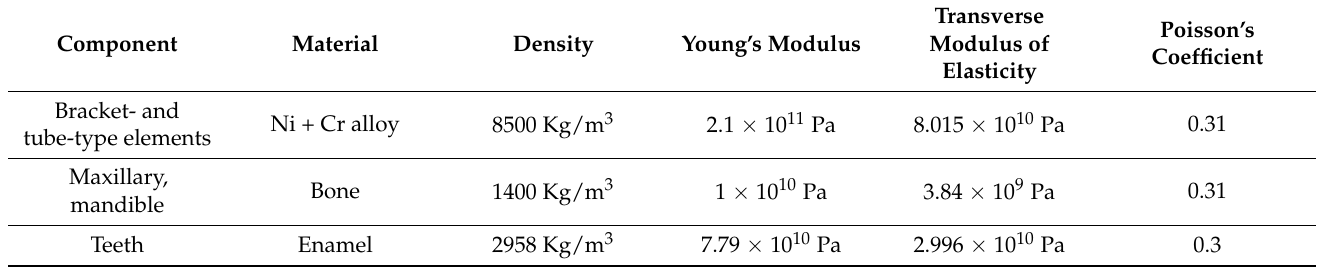
Table 10. Physical properties of materials used in the simulations.